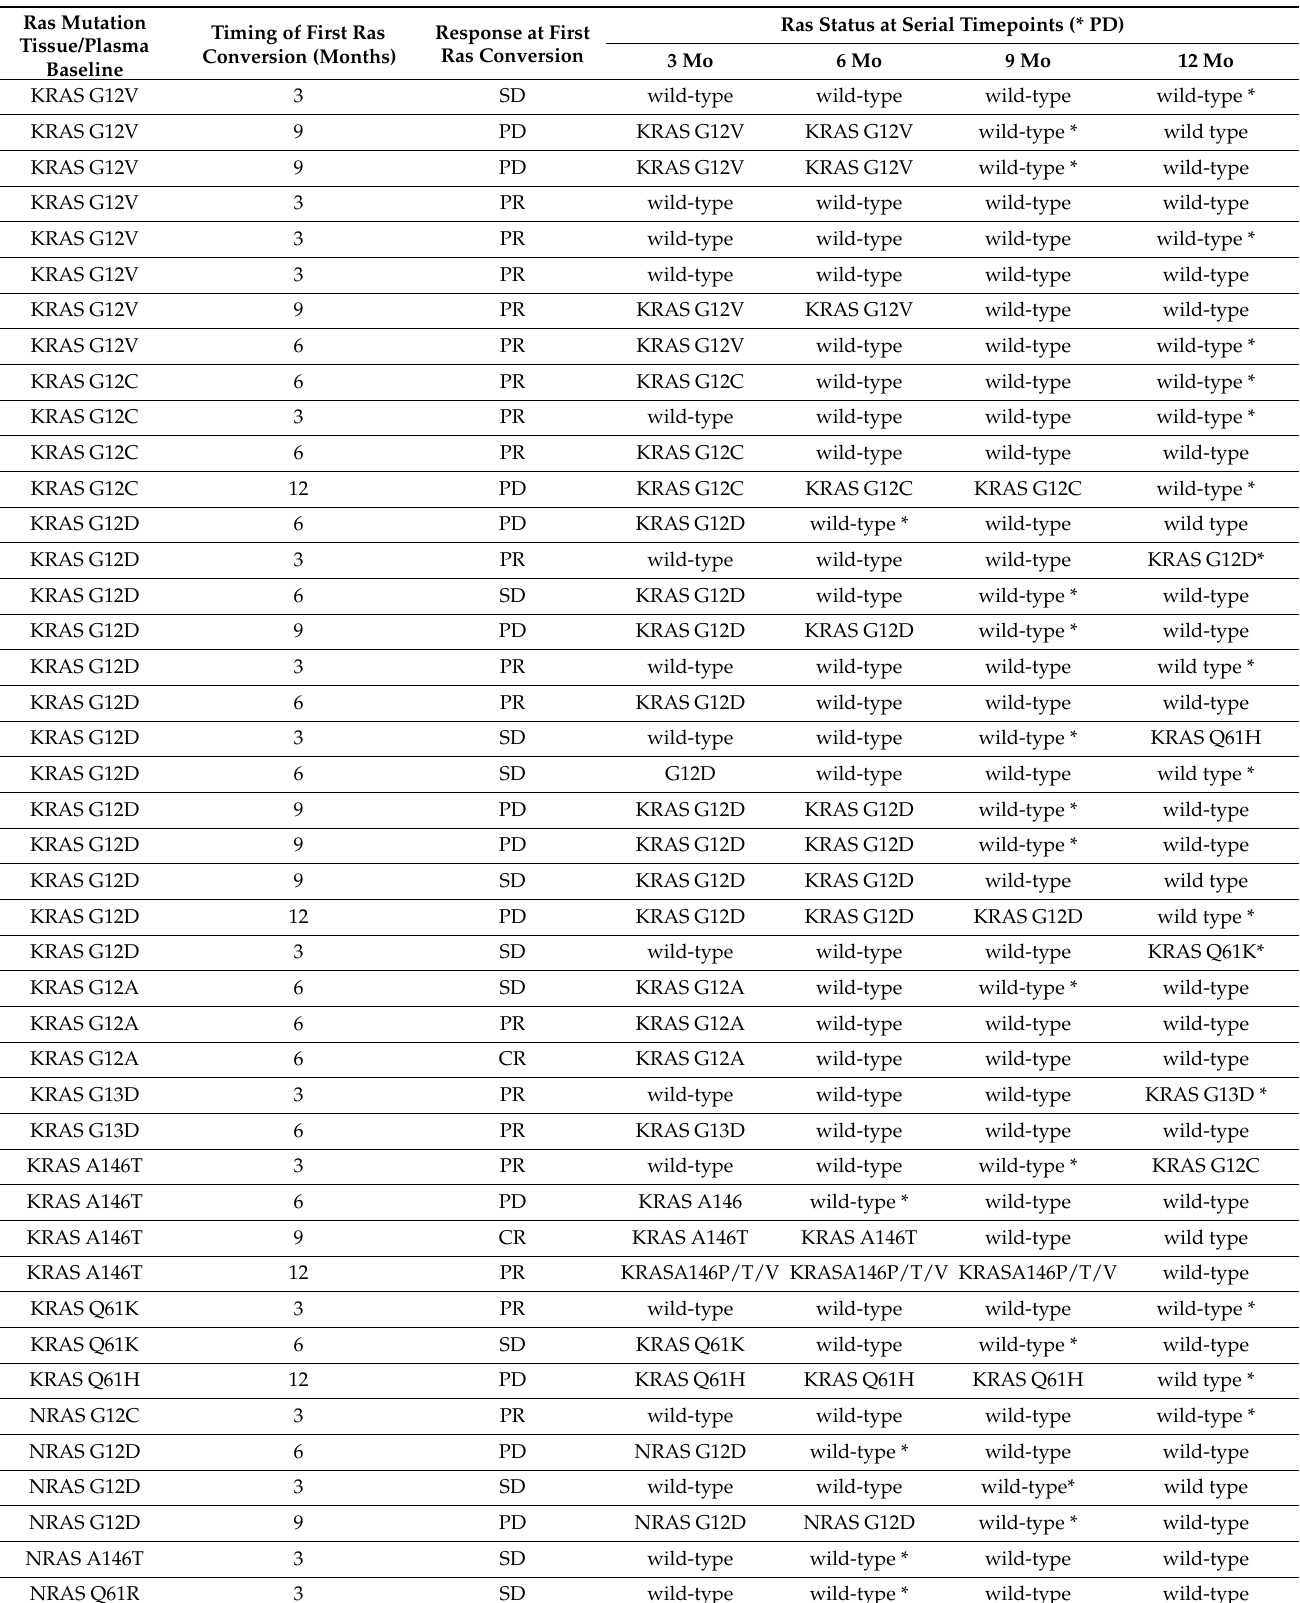
Table 3. Dynamics of the RAS conversion at different